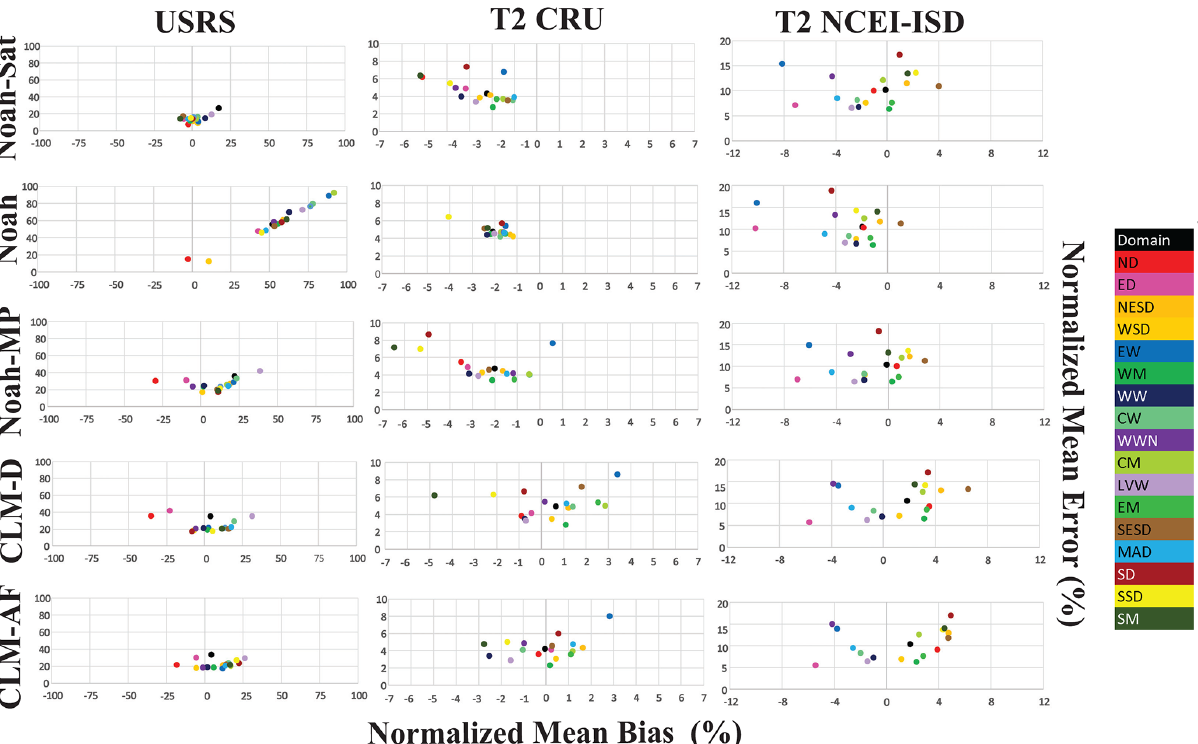
Figure 8. Normalized mean error and mean bias statistics of USRS and T2 relative to observations, CERES-EBAF USRS estimates, and CRU/NCEI